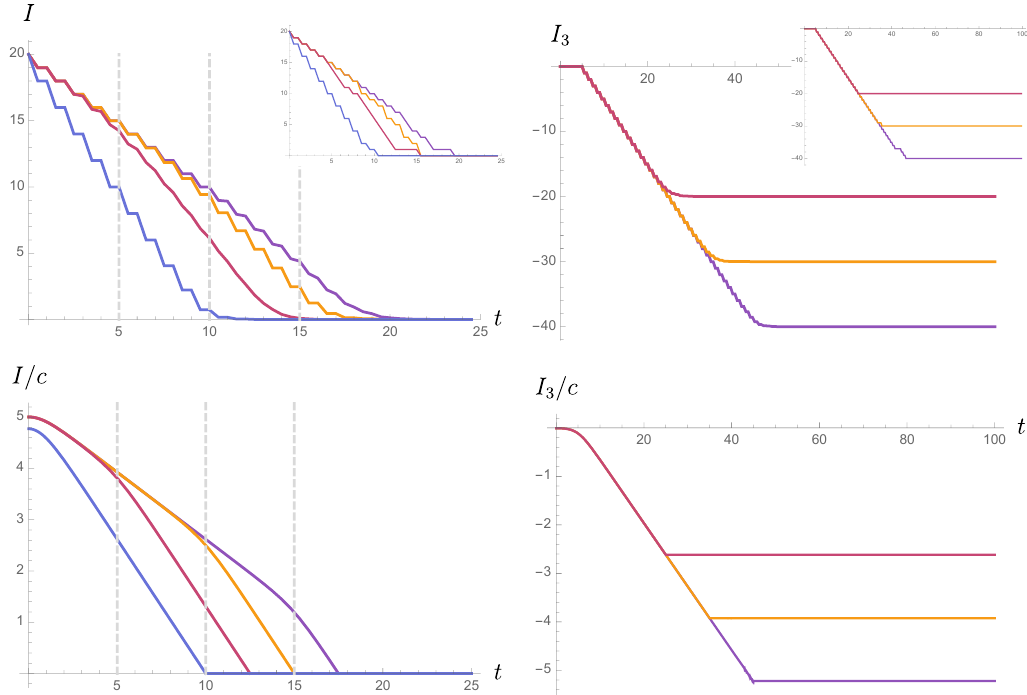
Figure 1 . Numerical simulation of Cli(cid:11)ord circuits. (top left) BOMI for asymmetric overlap with the left endpoints of the input and output intervals (cid:13)ush. The input interval is of length 10 and the output varies in length as 10 (blue), 15 (magenta), 20 (yellow), 25 (purple). The dotted gray lines are the times that the line-tension picture predicts the kink to occur at. (top right) TOMI for A of length 10 (magenta), 15 (yellow), 20 (purple). We average over 100 disorder realizations. The inset shows a single disorder realization. The mutual information is in units of log 2. These plots should be compared to the holographic results for the same con(cid:12)gurations that are shown in the bottom row. For the BOMI and TOMI, we use (cid:12) = 2 and (cid:12) = 4 respectively. The structure of the Cli(cid:11)ord circuit is brick-layered with CNOT gates and Hadamard and phase gates applied randomly on each site with probability 0 : 5 on every layer. The Hadamard and phase gates are essential for integrability breaking as we observe recurrence times of order L when only using CNOT gates (see (cid:12)gure